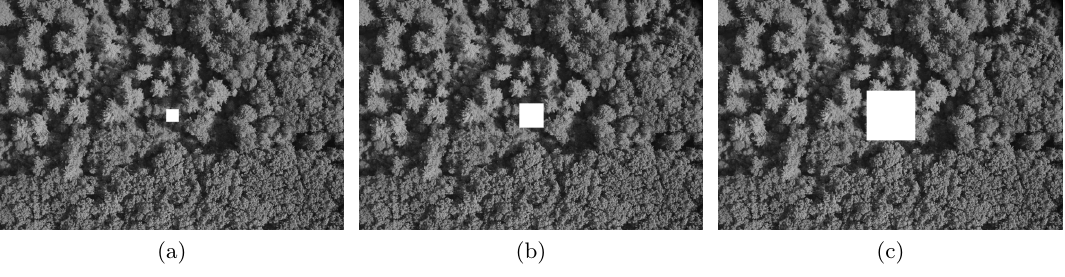
Figure 4. Gaps of missing observations of sizes 200 × 200 ( a ); 400 × 400 ( b ); and 800 × 800 ( c